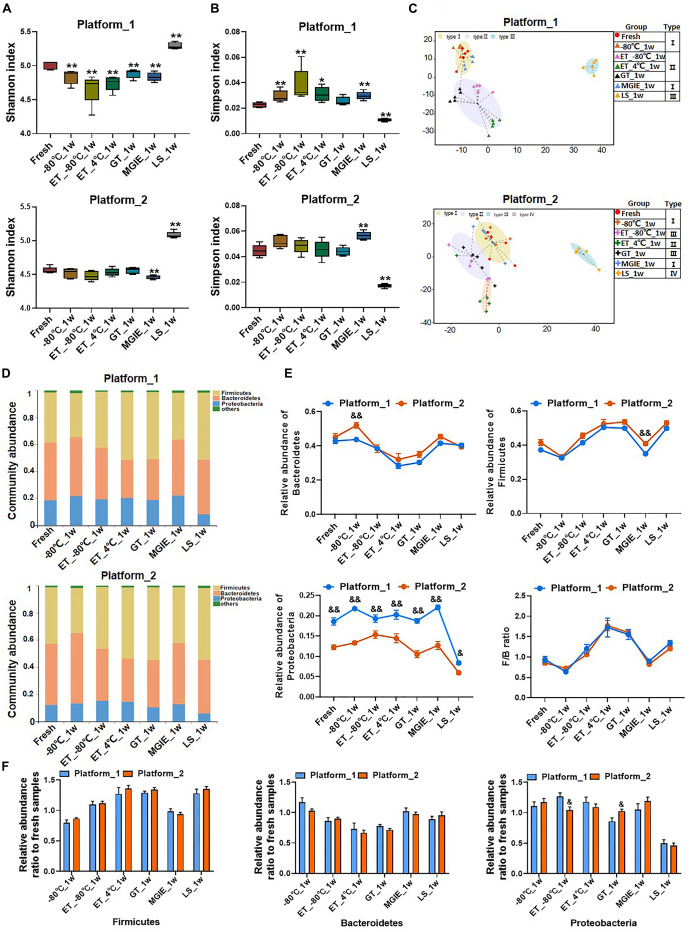
The impacts of different sequencing platforms on gut microbial profile. The community α diversity in platform_1 and platform_2 were analyzed by (A) Shannon diversity index and (B) Simpson diversity index. (C) The typing analysis on OTU level based on Jensen–Shannon Distance in platform_1 and platform_2. (D) Microbial communities under different storage conditions in platform 1 and platform_2. (E) The relative abundance of phyla Firmicutes, Bacteroidetes, Proteobacteria, and the ratio of Firmicutes to Bacteroidetes under different platforms. (F) The relative abundance ratio (stabilized samples to fresh samples) of the dominant phyla in different platforms. n = 5 per group. *p < 0.05, **p < 0.01, compared with fresh group; &p < 0.05, &&p < 0.01, compared with platform_1.